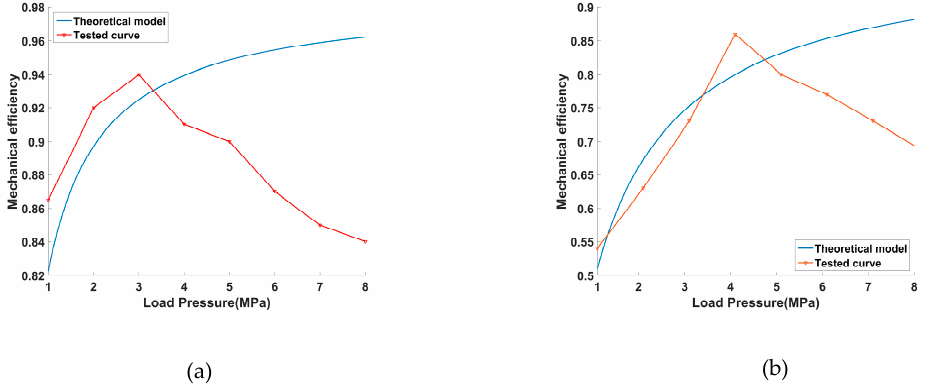
Figure 17. Comparison between the experimental and analytical results of the high-speed 2D piston pump. ( a ) At 1000 rpm; ( b ) at 5000 rpm.